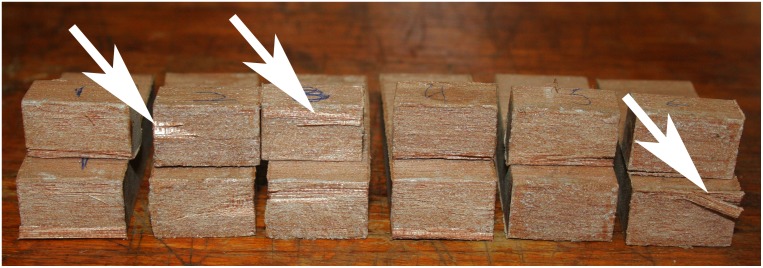
Photograph showing bonded surfaces of wood adherends with 100% acacia gum after the impact tests.All specimens exhibit some form of substrate failure, though some are more severe than others. The arrows point to areas where the wood failed but the adhesive remained bonded.